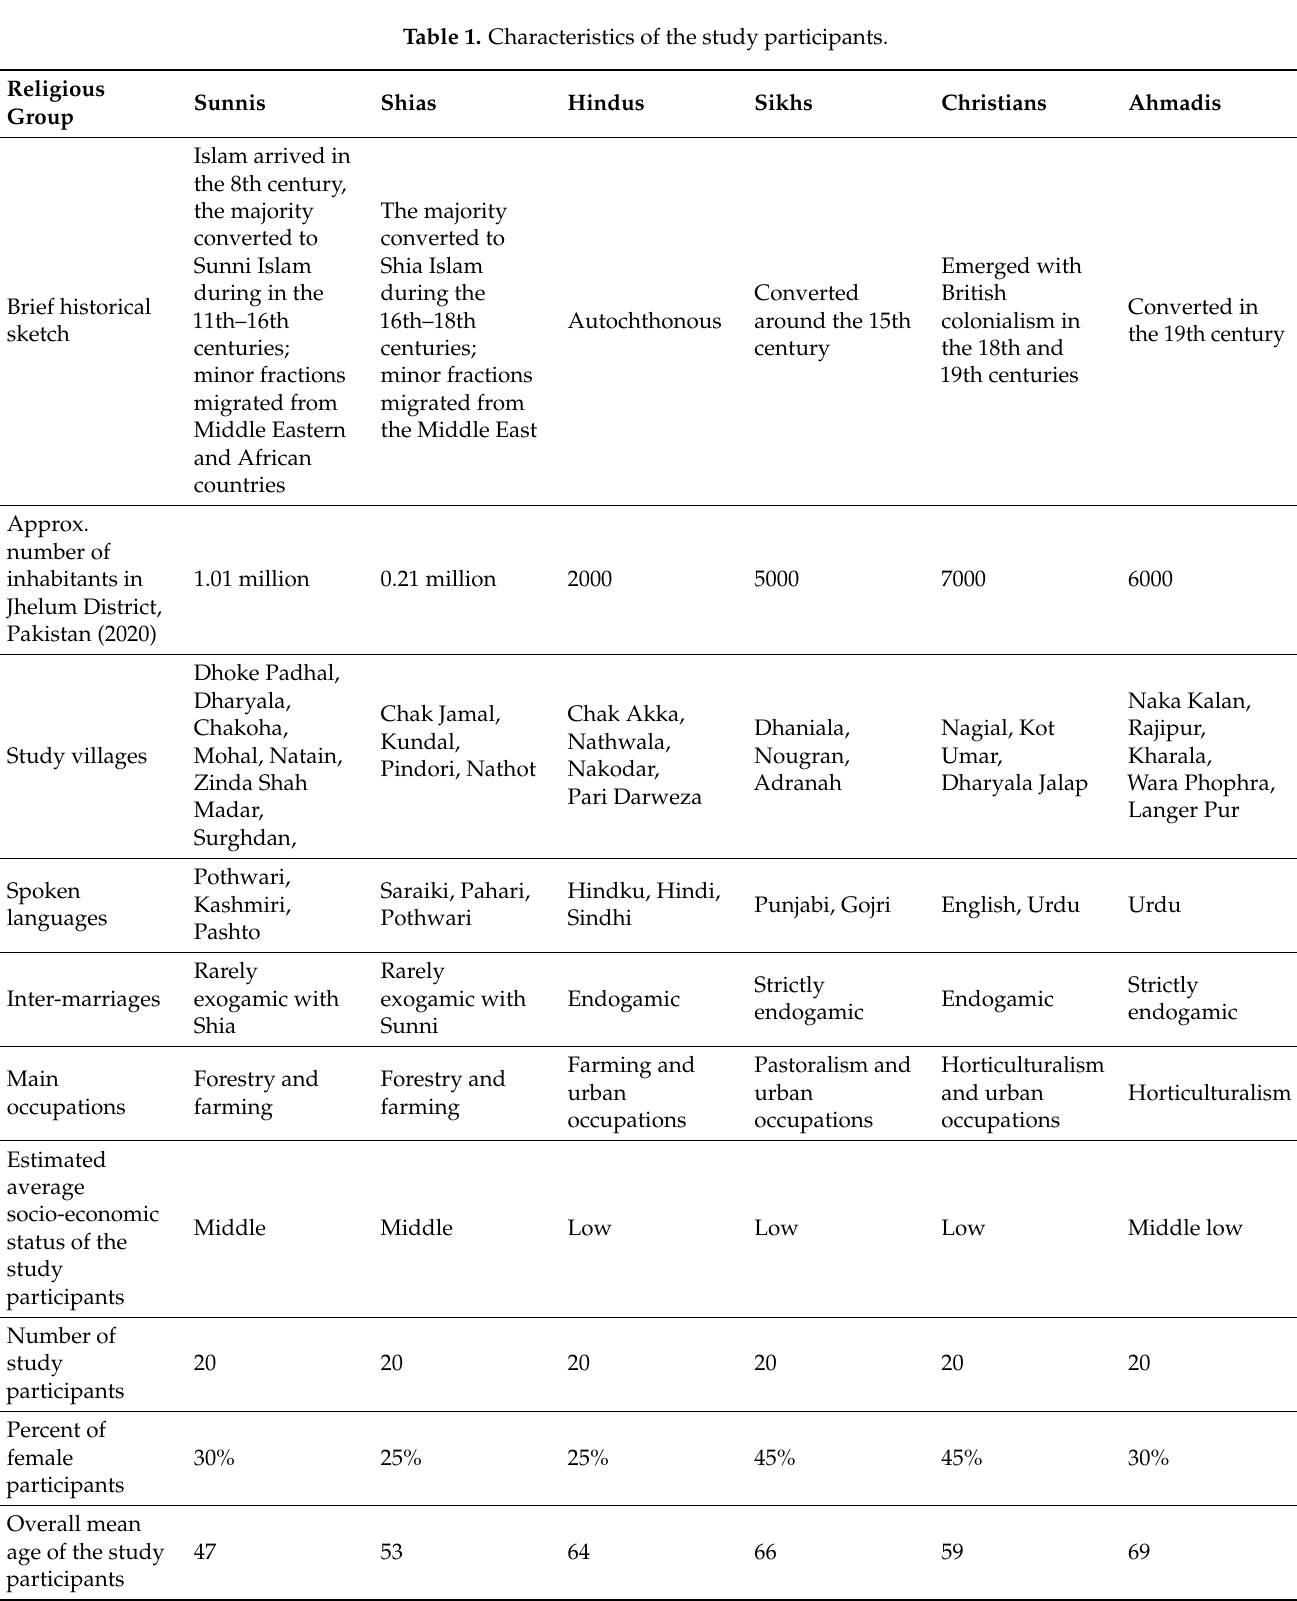
Table 1. Characteristics of the study